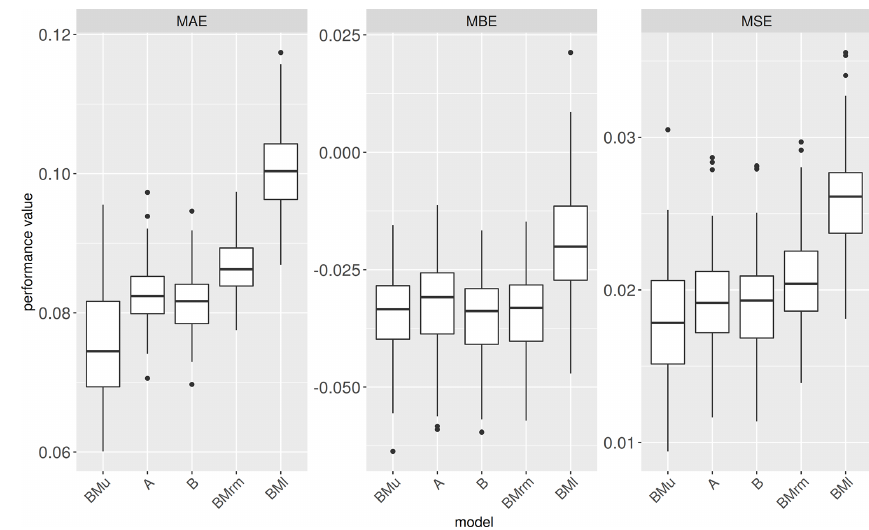
Figure 6. Performance metrics of OSM-based models and benchmark models. Table 5. Model precision, accuracy and reliability performance metrics for OSM-based models and benchmark models.